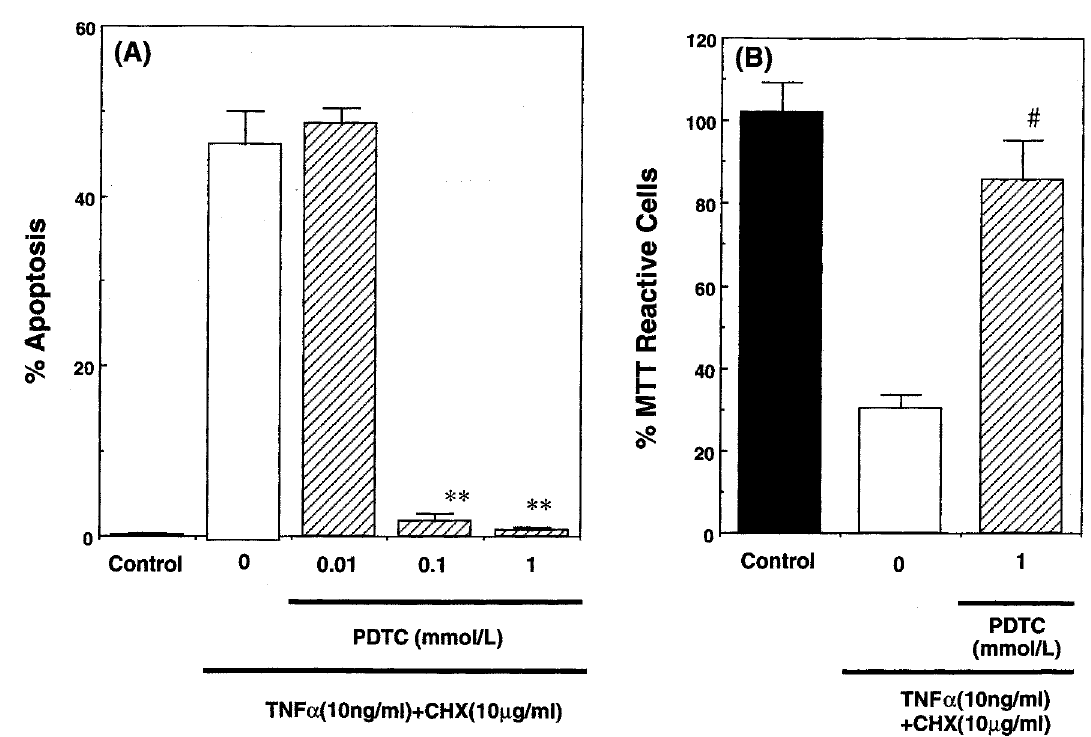
FIG. 2. PDTC-inhibited TNF a and cycloheximide-induced apoptosis of endothelial cells. (A) Endothelial cell monolayers were treated with TNF a (10ng/ml) and cycloheximide (10 m g/ml) in various concentrations of PDTC (0–1mmol/l) for 6h. After the incubation treatment, the cells were stained with propidium iodide, as described in Materials and methods. ** P <0.01 versus TNF a and cycloheximide-treated group. Each experiment was repeated three times. (B) Endothelial cell monolayers were treated with TNF a (10ng/ml) and cycloheximide (10 m g/ml) in the presence or absence of PDTC (1mmol/l) for 6h. After the incubation treatment, the cells were stained with MTT, as described in Materials and methods. The data show the mean±SEM for eight wells. # P <0.05 versus TNF a and cycloheximide-treated group. Each experiment was repeated three